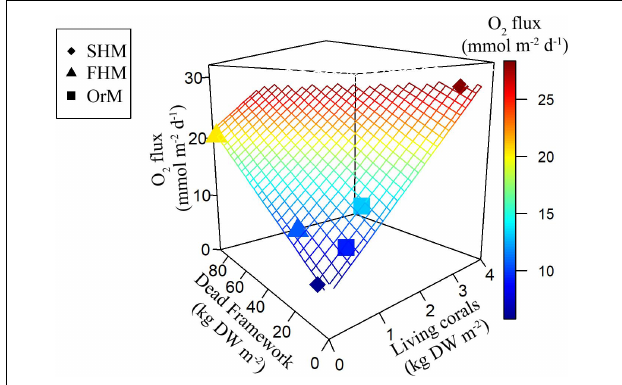
FIGURE 7 | Planar regression of the O 2 flux (mmol m − 2 d − 1 ) against the predictor variables living coral density (kg dry weight m − 2 ) and dead coral framework density (kg dry weight m − 2 ), of which the intercept is interpreted as sedimentary O 2 flux. The six incubated boxcores are plotted as individual datapoints and plane represents results of the regression model. Note that the symbols in the plot are shape according to their location (see legend) and colored according to the observed O 2 flux. Plot produced with R package plot3D (Soetaert, 2017).